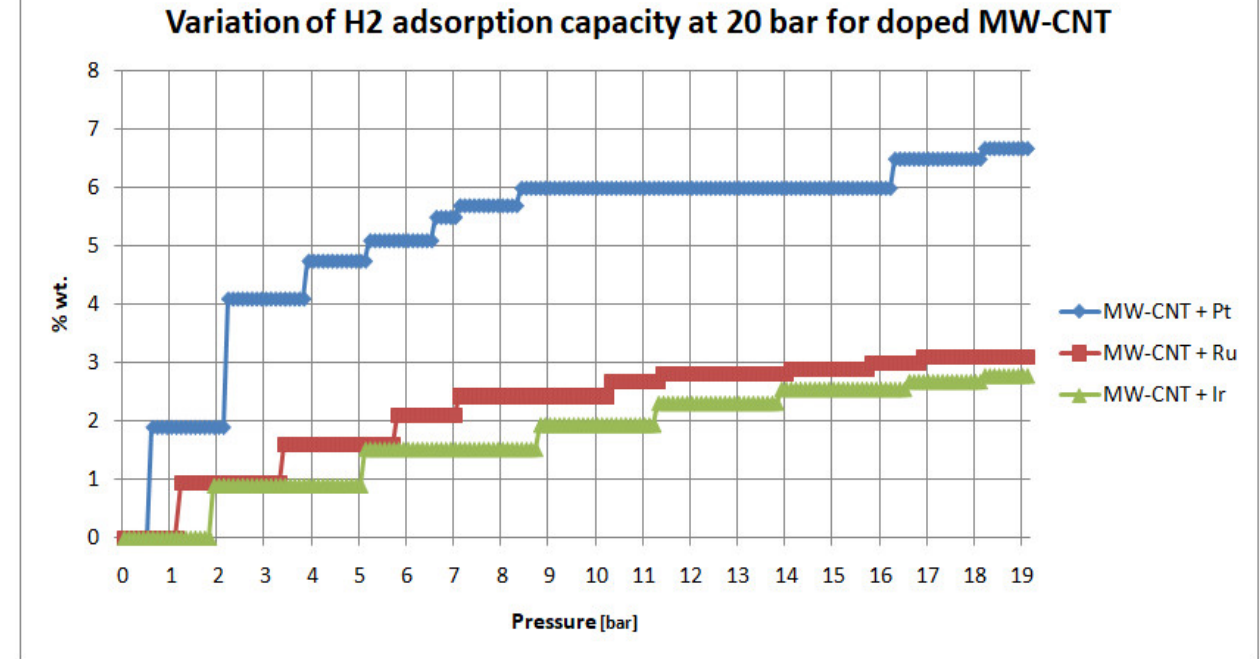
Figure 6. Metal-doped MW-NT H 2 -adsorption-capacity determination at 20 bar.